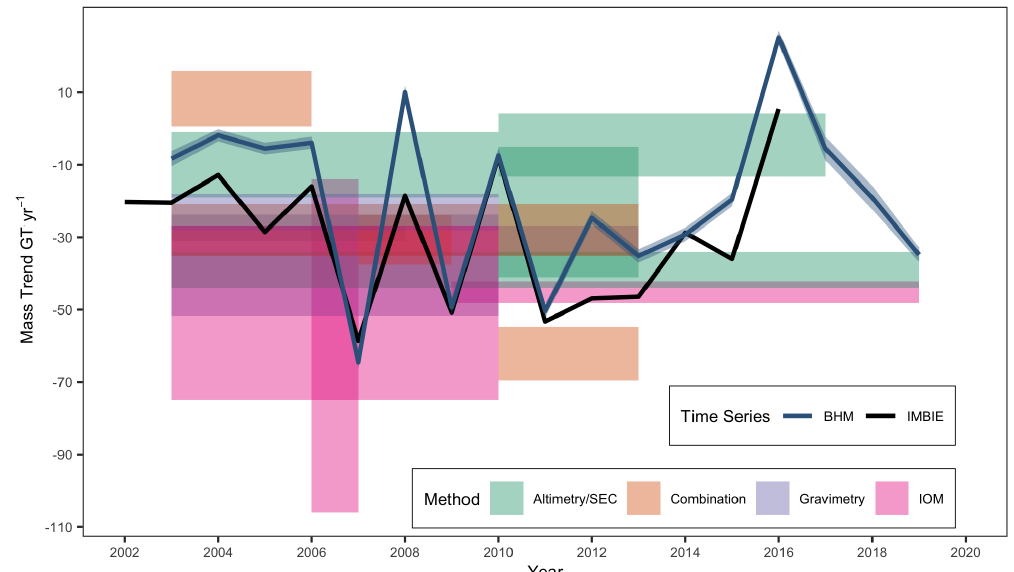
Figure 8. Comparison of total mass trends for the AP from the BHM (blue line, with 1 σ uncertainty ribbon) with time-averaged epoch studies for the same sector (colour shaded boxes – see Table S1 for list of studies) and the annual mass trends from the IMBIE exercise (Shepherd et al., 2018). Details of the processing for the comparison datasets can be found in Sect.